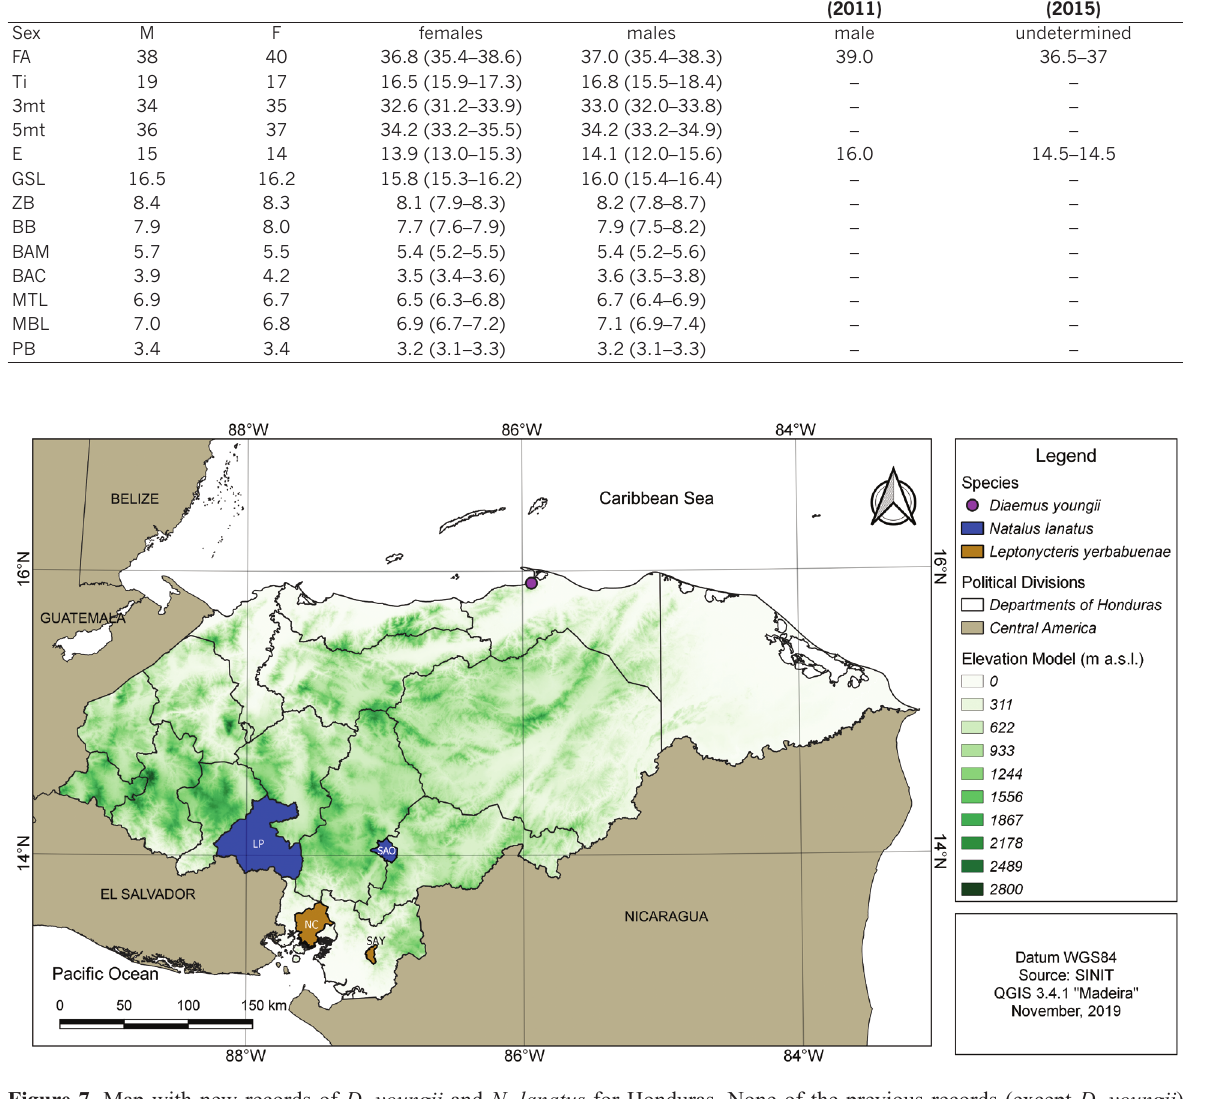
Figure 7. Map with new records of D. youngii and N. lanatus for Honduras. None of the previous records (except D. youngii ) have exact coordinates, however, we shaded the municipality on each department in which they were recorded. The blue shaded area indicates the localities of N. lanatus captured in the municipality of Zamorano (municipality of San Antonio de Oriente)